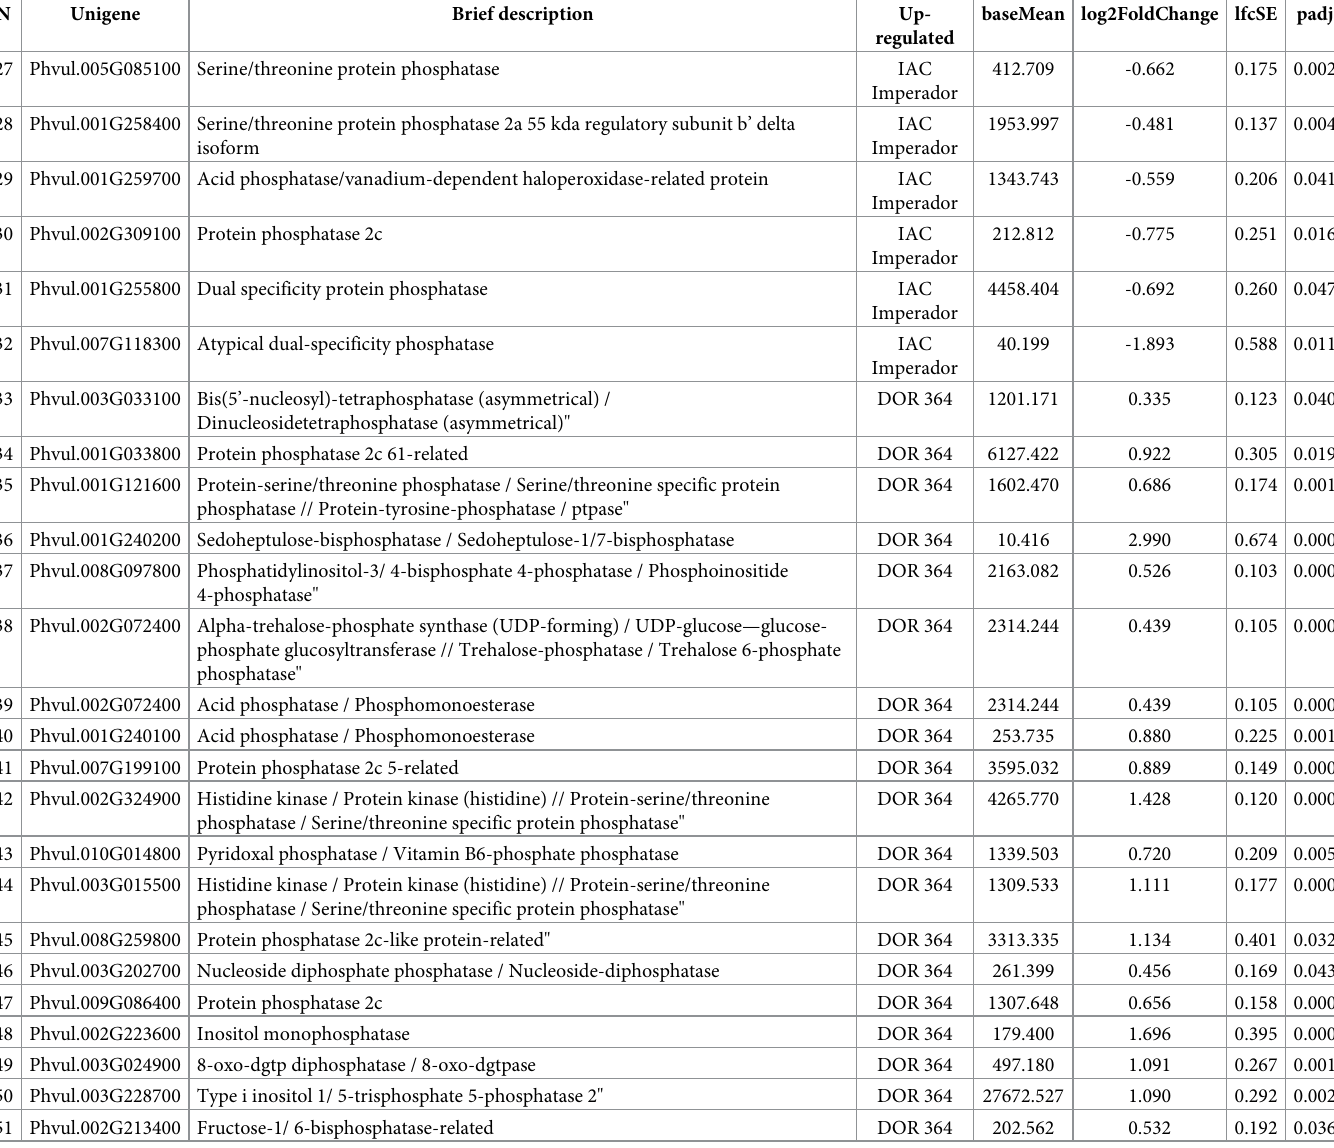
of the protein histidine kinase complex. The molecular function category exhibited 15 subcate- gories of gene ontology, with the most frequent codifying domains related to oxidoreductase